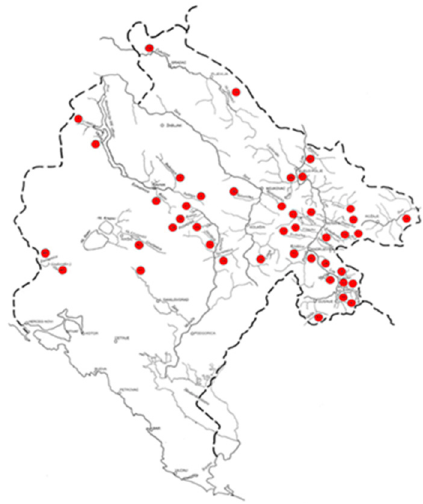
Figure 1. Locations where SHPPs are envisaged